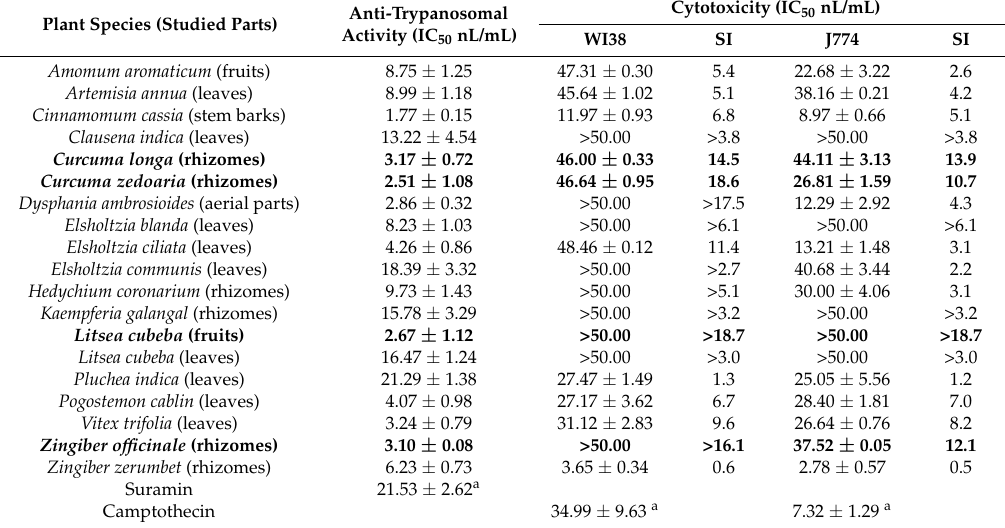
Table 1. Anti-trypanosomal activity, cytotoxicity, and selectivity indices of the 19 selected EOs.